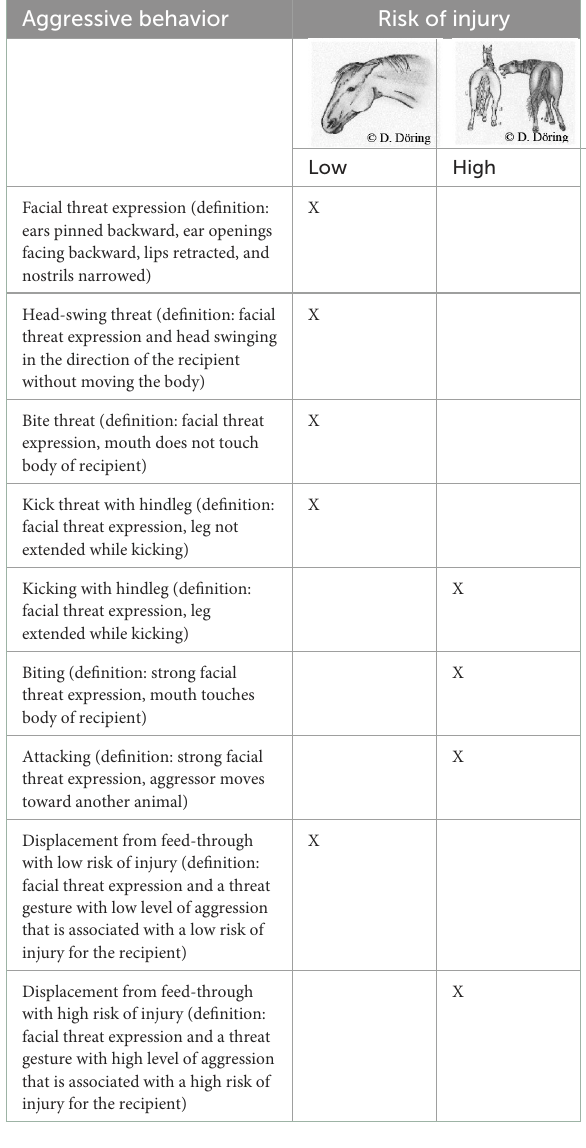
TABLE 1 Categories of the behavioral parameter “aggressive behaviors” [modified after (25, 26)]. Aggressive behavior Risk of injury